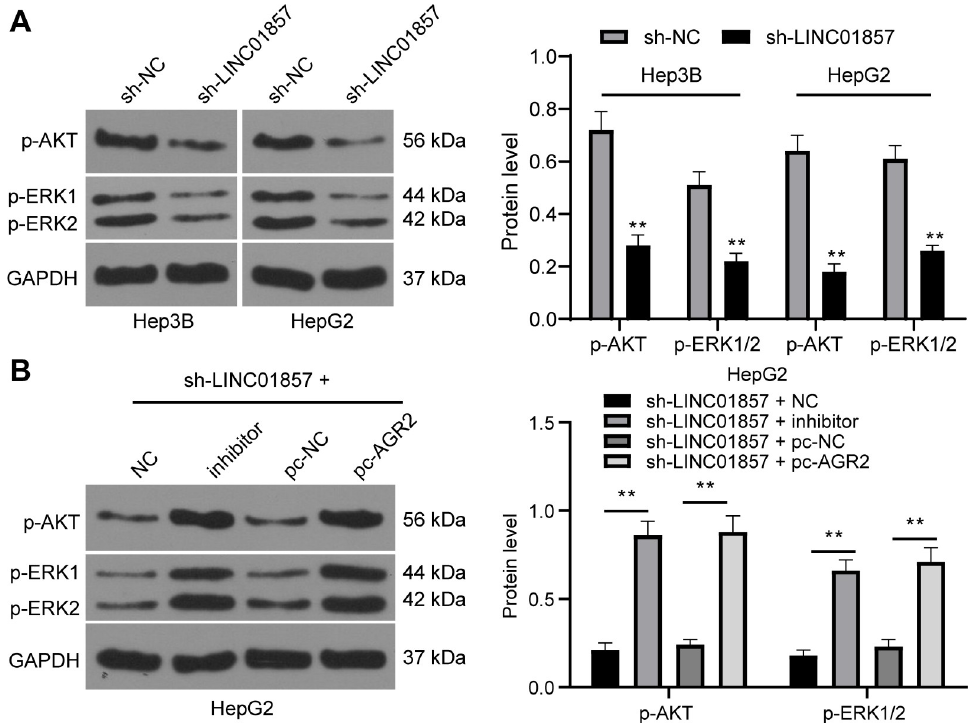
Fig 6. LINC01857 activates the AKT and ERK pathways by mediating the miR-197-3p/AGR2 axis. A and B, protein levels and phosphorylation levels of AKT and ERK in HCC cells from different groups verified by western blot analysis. Three independent repeated tests were conducted. The results were presented as mean ± standard deviation. Two-way ANOVA was employed to analyze the data. Tukey’s multiple comparisons test was applied for the post hoc test. �� p <